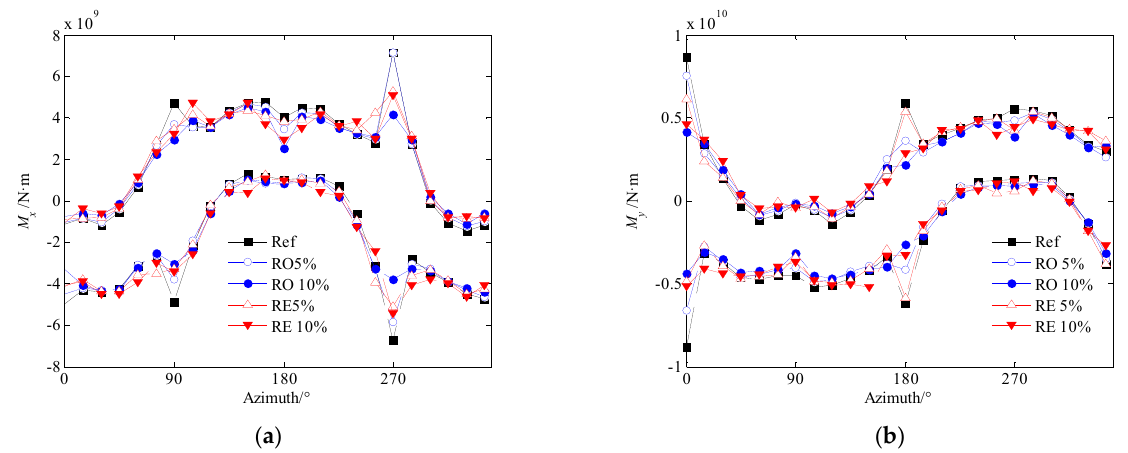
Figure 8. Wind-induced base overturning moments: ( a ) M x ( b ) M y . Table 3. The comparison of wind-induced moments in y direction (Unit: 10 9 N·m).